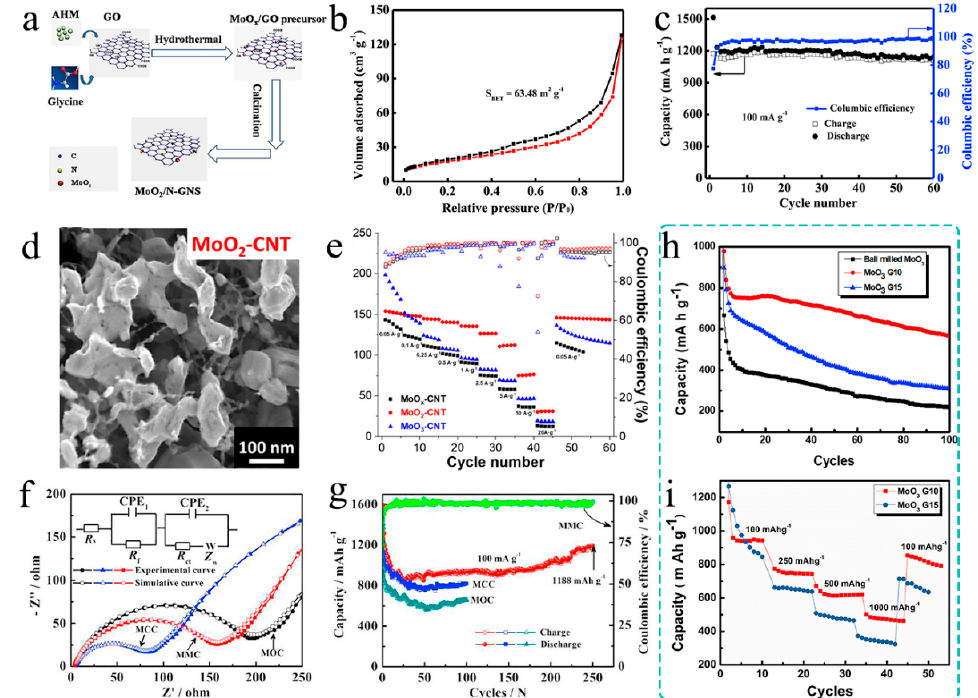
Figure 4. ( a ) Schematic illustration of the synthesis procedure of MoO 2 /N-GNS hybrid. ( b ) N 2 adsorption–desorption isotherm. ( c ) Capacity vs. cycle number and the corresponding coulombic efficiency of MoO 2 /N-GNS hybrid electrode. Reproduced with permission. [63] Copyright 2014, Elsevier B. V. ( d ) SEM of MoO 2 -CNT after annealing at 500 °C in an argon atmosphere. ( e ) Specific de-lithiation capacity and coulombic efficiency derived from galvanostatic cycling at specific currents between 0.05 and 20 A·g − 1 . Reproduced with permission. [64] Copyright 2018, American Chemical Society. ( f ) The pore size distributions of MOC, MMC, and MCC samples. ( g ) The discharge–charge of MOC, MMC, and MCC samples at the current density of 100 mA g − 1 . Reproduced with permis- sion. [65] Copyright 2017, Elsevier B. V. ( h ) Galvanostatic tests of ball-milled MoO 3 , MoO 3 -10 wt % rGO, and MoO 3 -15 wt % rGO. ( i ) Rate performance of MoO 3 -10 wt % rGO and MoO 3 -15 wt % rGO. Reproduced with permission. [66] Copyright 2019, Elsevier B.V. For an in situ synthesis method, Chai’s group [65] reported MoO 2 -Mo 2 C-C micro- spheres (MMC) synthesized via in situ carbonization as anode materials for lithium-ion batteries. Figure 4f shows the electrochemical impedance spectroscopy (EIS) of the mate- rials. Obviously, carbon doping could reduce the charge transfer resistance, leading to a better electron conductivity, and ultimately enhance the diffusion of lithium ions to the MMC samples. Owing to the combination of the higher conductivity of Mo 2 C, C and the appropriate content of Mo 2 C, the MMC microspheres exhibit excellent cyclability and good stability. As shown in Figure 4g, for the MMC electrode, the initial discharge/charge specific capacities are nearly 1594/1171 mA h g − 1 at 100 mA g − 1 , respectively, with a rela- tively low coulombic efficiency of 73.5%. The loss capacity was accorded with the irre- versible procedure, including the insertion of Li + into the MoO 2 lattice and the formation of solid electrolyte interface (SEI) film. However, this material visibly delivers an excellent discharge capacity of 1188 mA h g − 1 after 250 cycles. Recently, Li et al. [67] produced ex- tremely small and widely dispersed MoO x nanoparticles anchored on N-doped three-di- mensional delaminated porous carbon (3D-MoO x @CN) based on an efficient in situ che- lation and hard induction strategy. The MoO x nanoparticles anchor on the surface of the 3D N-doped carbon with sizes between 1.5 and 3.5 nm. Therefore, the volume change during charge and discharge can be effectively mitigated, while the three-dimensional carbon skeleton can provide a conductive network, thus improving the lithium storage